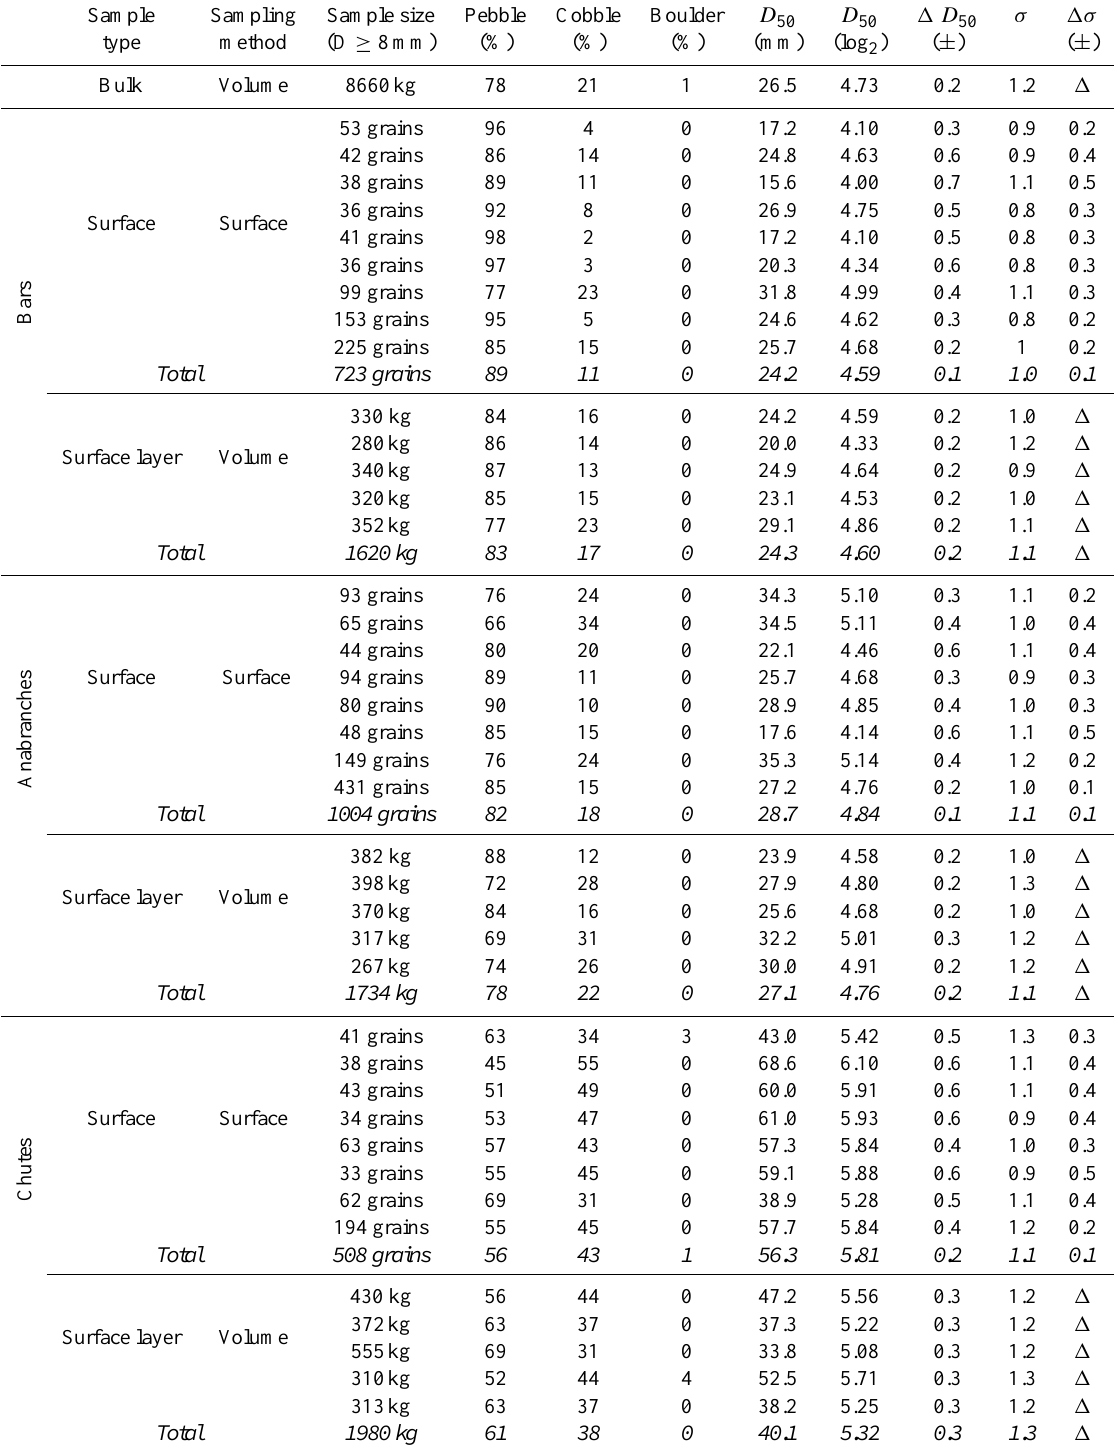
Table 1. Statistics of the GSDs. D 50 (mm) is the mean diameter of the distributions, D 50 (log 2 ) the mean diameter of the φ -normalized dis- tributions ( D 50 (log 2 ) = log 2 ( D 50 )(mm)), and 1D 50 the associated uncertainty. σ is the standard deviation of the φ -normalized distributions and 1σ the associated uncertainty. Grain-size classes are from Wentworth